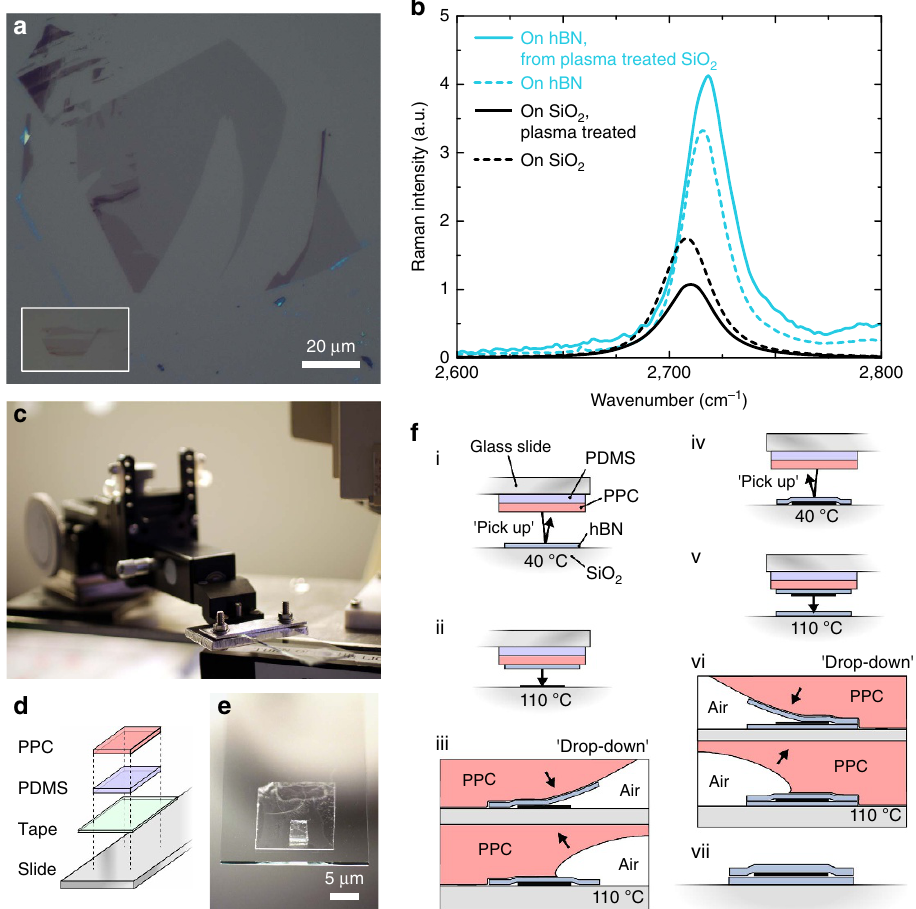
Figure 1 | Assembly and precharacterization of heterostructures. ( a ) Monolayer graphene flakes produced on oxygen plasma-treated SiO 2 . Inset (white square): typical graphene flake size on non-plasma-treated SiO 2 . To scale with ( a ). ( b ) Graphene Raman 2D peak dependence on substrate – the Raman I (2D) /I ( G ) ratio increases for graphene picked up with hBN from SiO 2 irrespective of the oxygen plasma pre-treatment of the substrate. ( c ) Micromanipulator with slide assembly used for assembly of heterostructures. ( d , e ) Polymer stack on glass slide used for pick-up and drop-down. ( f ) Schematic process flow for assembly of 2D heterostructures by pick-up and